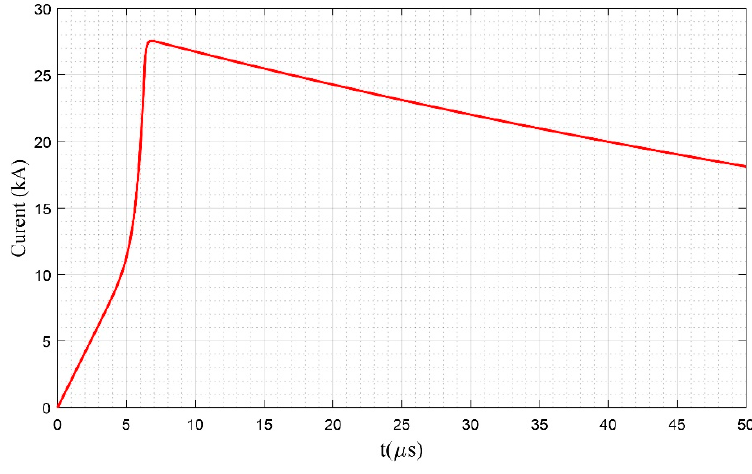
Figure 1. Lightning current impulse.